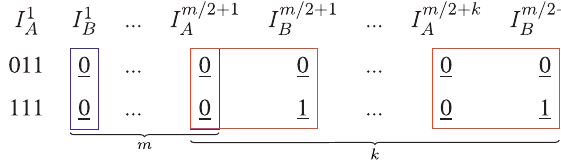
Frontiers in Applied Mathematics and Statistics |